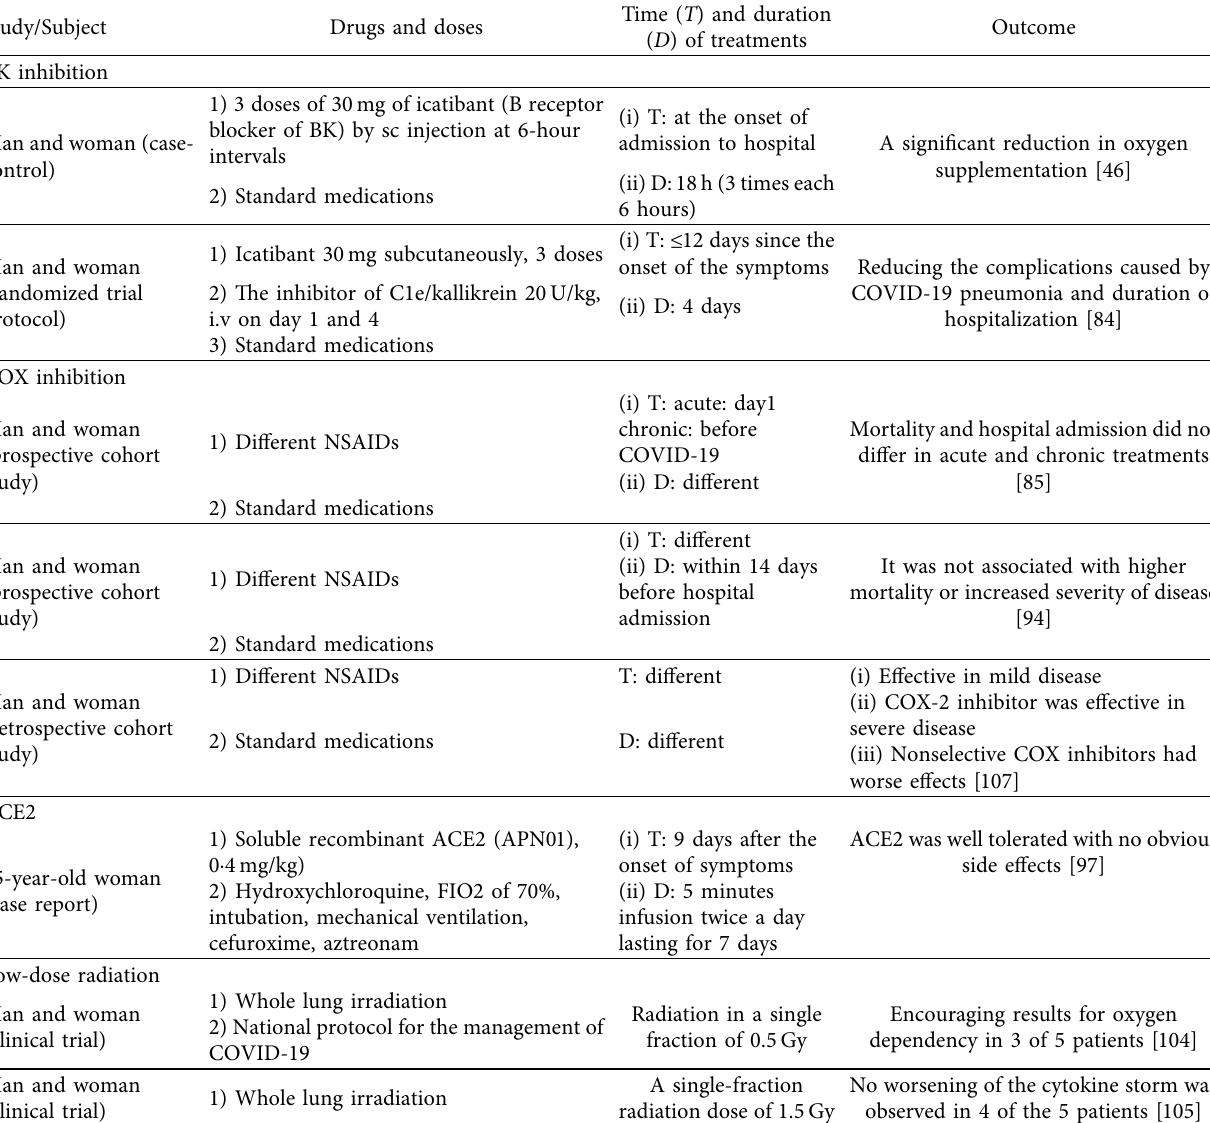
Table 2: Drug administration in patients with